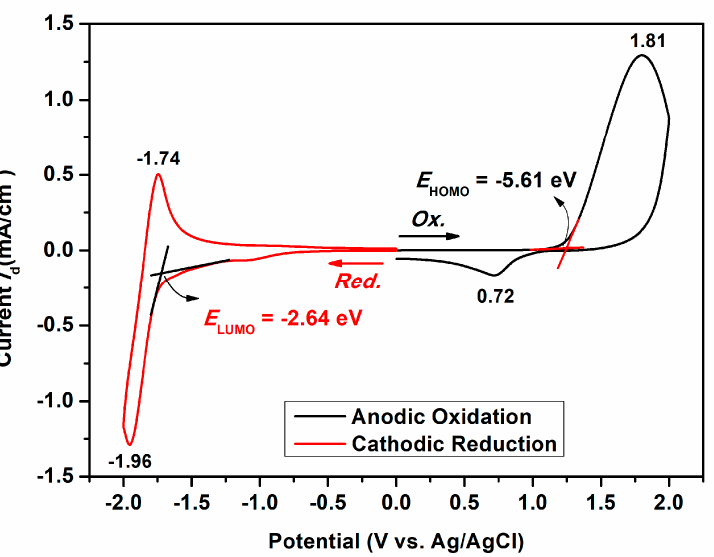
Figure 9. Cyclic voltammograms of the polyamide 5a film on ITO-coated glass substrate in 0.1 M Bu 4 NClO 4 /CH 2 Cl 2 (for oxidation trace) and DMF (for reduction trace) solutions at a scan rate of 50 and 100 mV/s, respectively.